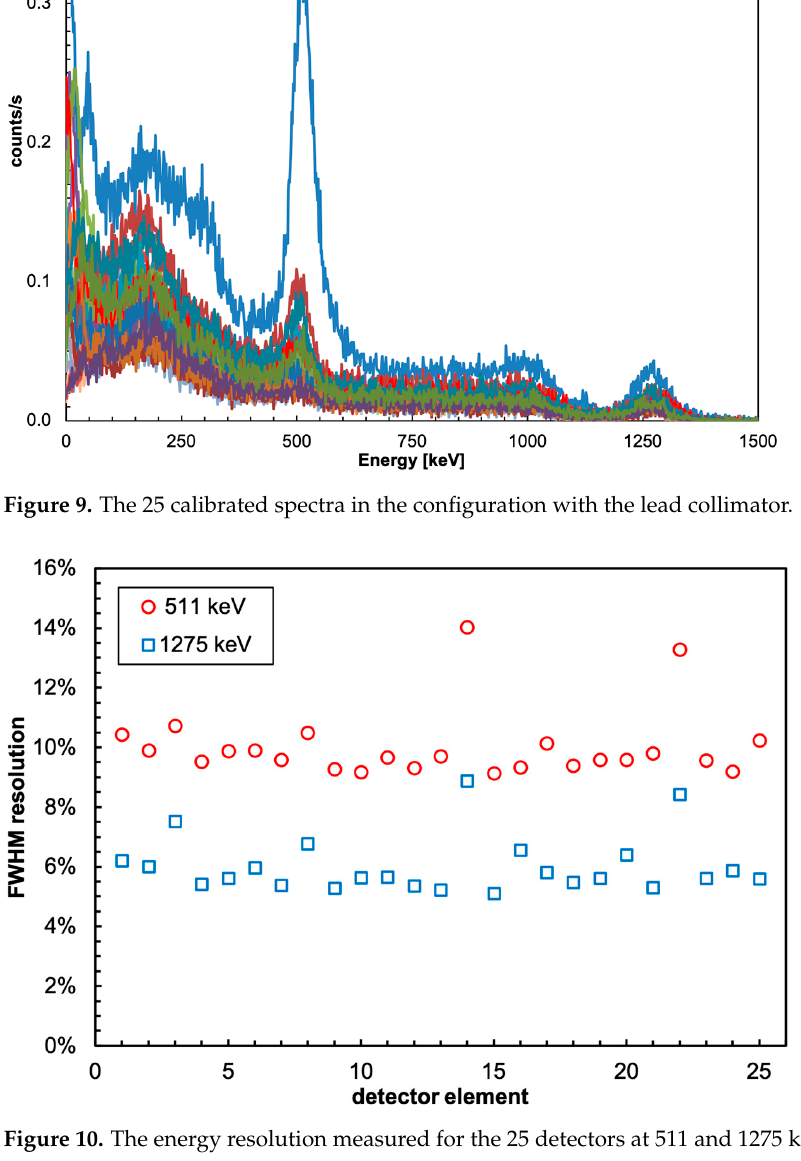
Figure 10. The energy resolution measured for the 25 detectors at 511 and 1275 keV.